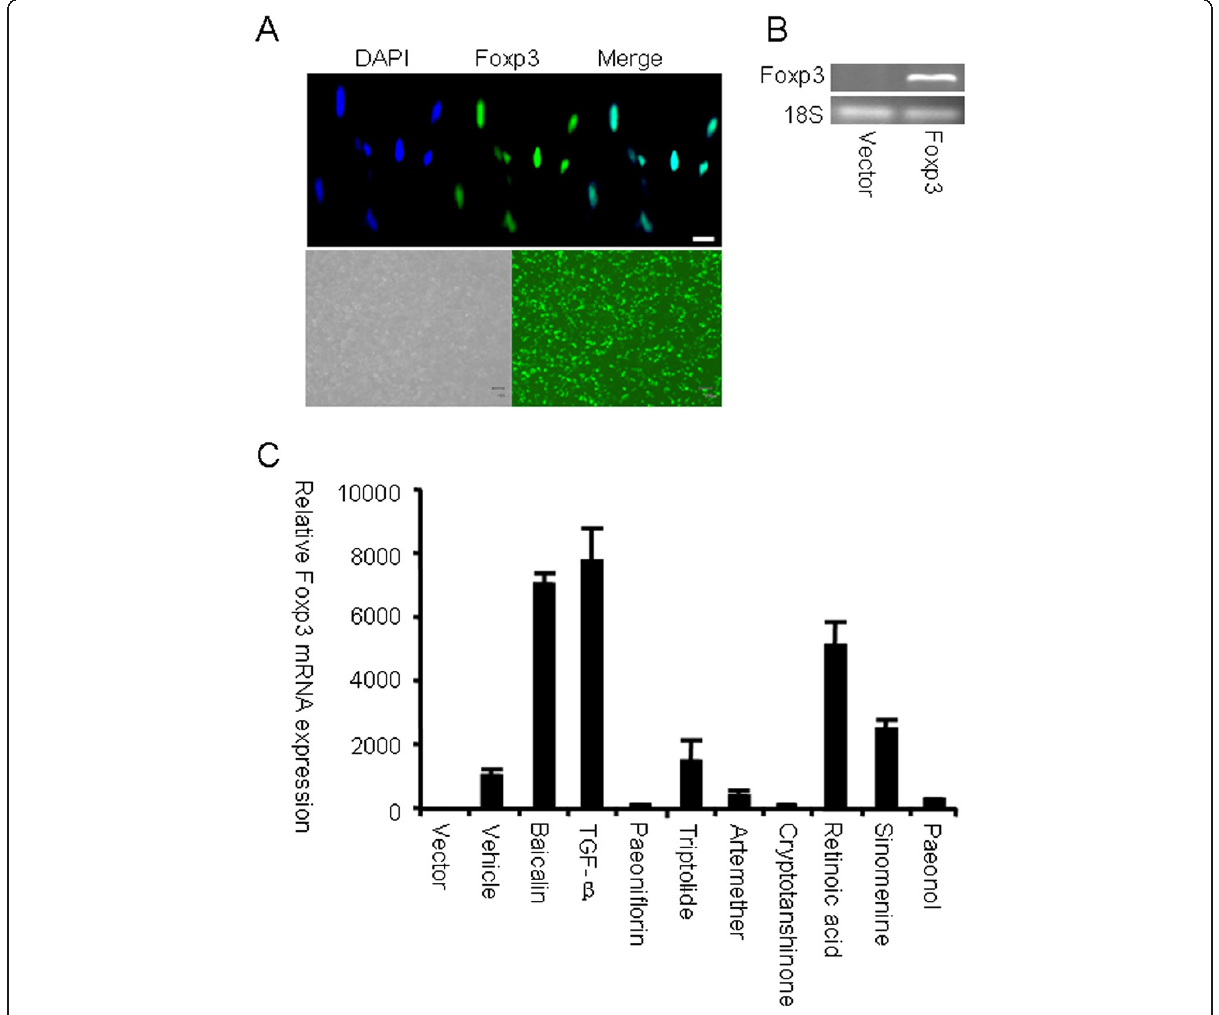
Figure 1 Screening of compounds that up-regulate Foxp3 expression. HEK 293 T cells were transfected with Foxp3 expression plasmids. ( A ) Nuclear expression of Foxp3 in HEK 293 T cells was examined by immunofluorescence microscopy. Scale bar, 10 μ m. ( B ) Foxp3 mRNA expression in transfected HEK 293 T cells was determined by RT-PCR. ( C ) Twenty-four hours after transfection, cells were then treated with different compounds for another 24 h. Foxp3 mRNA expression was analyzed by real-time RT-PCR. Data are expressed as mean±SD, and compared with vector control (expression level of vector control was set as 1.0). Shown are results from three independent